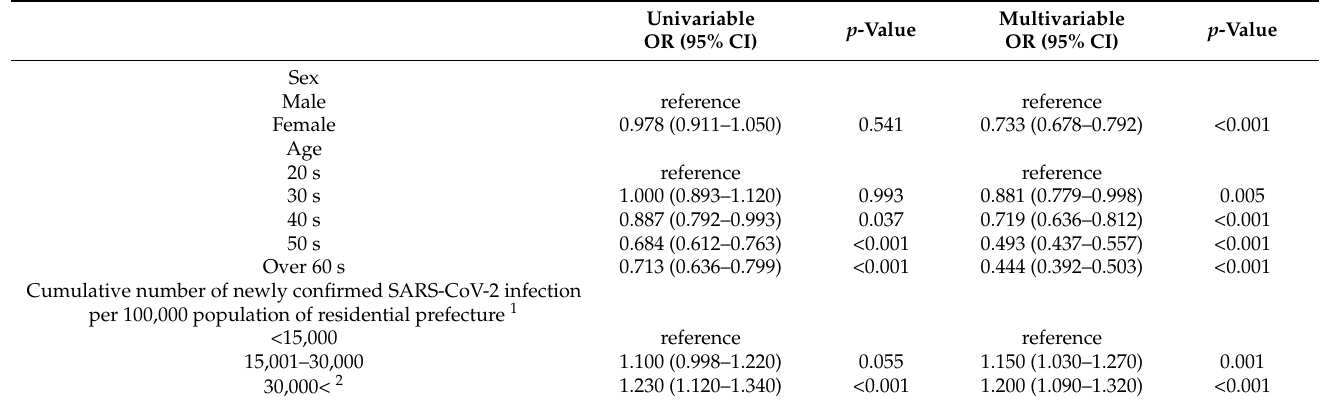
Table 6. Factors associated with dietary supplement usage for the prevention of SARS-CoV-2